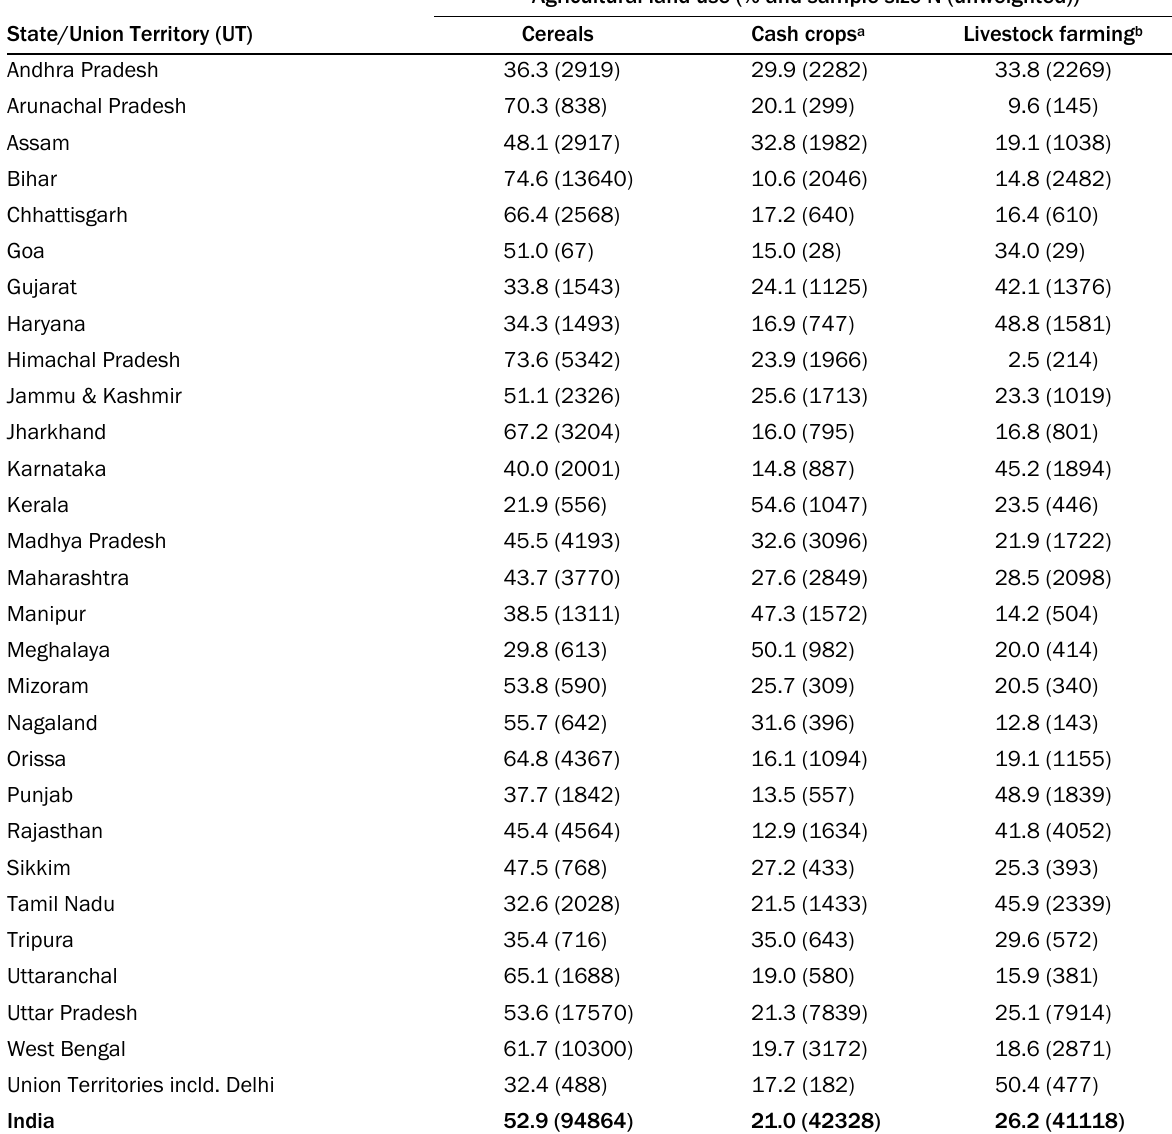
Table 1. Land Use (%) Under Agriculture and Allied Activities by States/Union Territories, India,